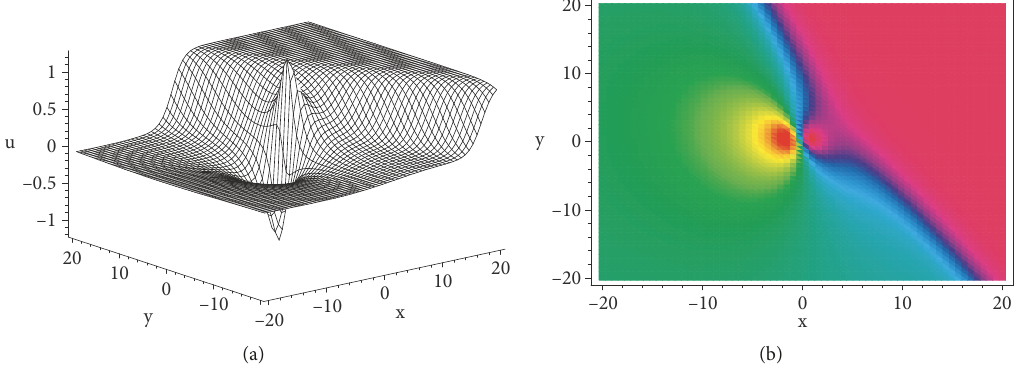
Figure 2: The interaction solution between a lump and a one-kink soliton of (10). (a) 3-dimensional plot with the time 𝑡 = 0 ; (b) the corresponding density